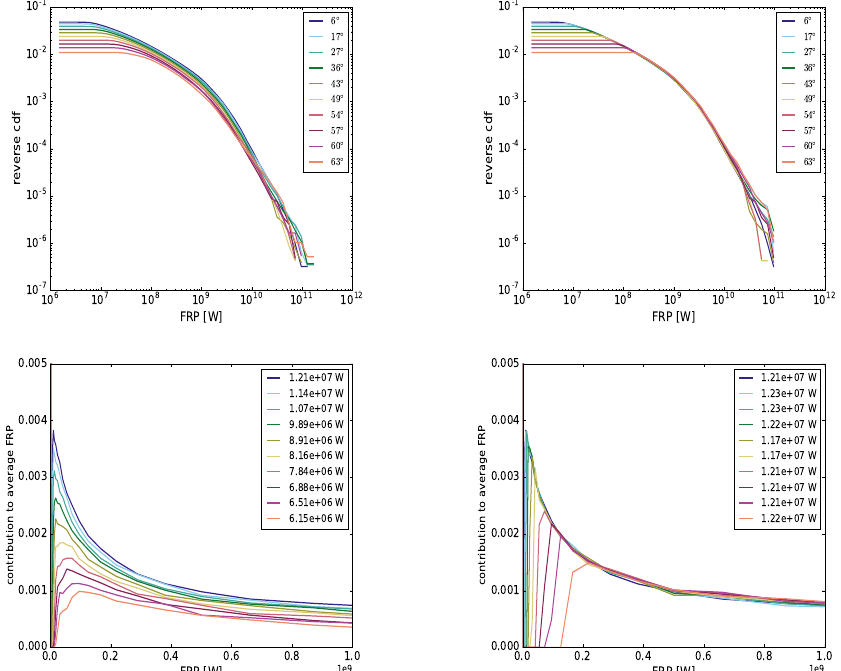
0.0000.0010.0020.0030.0040.005 Figure 3. Statistical properties of Moderate Resolution Imaging Spectroradiometer (MODIS) gridded-FRP observations (hourly, 2017) before and after bias correction. The observations have been corrected according to the correction factors described in Figure 1. The rows from top to bottom describe the number of observations, probability density function (PDF), CDF, and average FRP contribution respectively. The ( left column ) shows the statistics from uncorrected gridded-FRP on a 1 ◦ grid; and the ( right column ) shows the statistics from bias corrected gridded-FRP on a 1 ◦ grid. The lowest bin, which includes the FRP = 0 observations, is omitted from the plots of PDF and CDF. The corrected gridded-FRP observations shown in this figure are used for Visible Infrared Imaging Radiometer Suite (VIIRS) comparison in the next